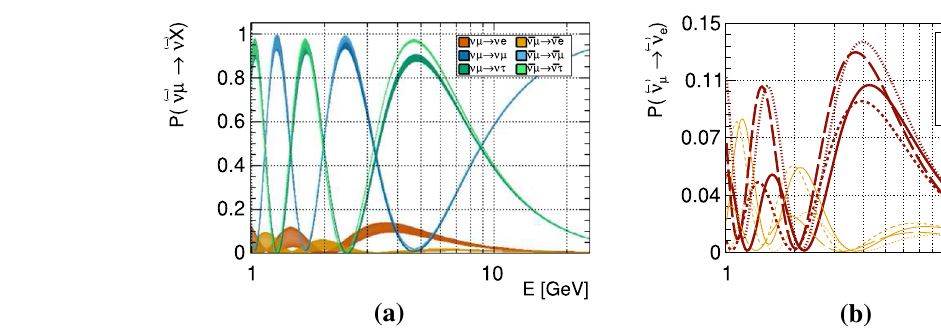
(dashed line) and NO below. A zoom in the NO region is shown in b . The blue lines represents the probabilities for a given δ CP value when the energy is varied. At high energy both probabilities are null as no oscillation occurs. In both a and b , the oscillation baseline is 2595 km. TheprobabilitiesarecomputedwiththeOscProbsoftwarepackage[41] and using the oscillation parameters from